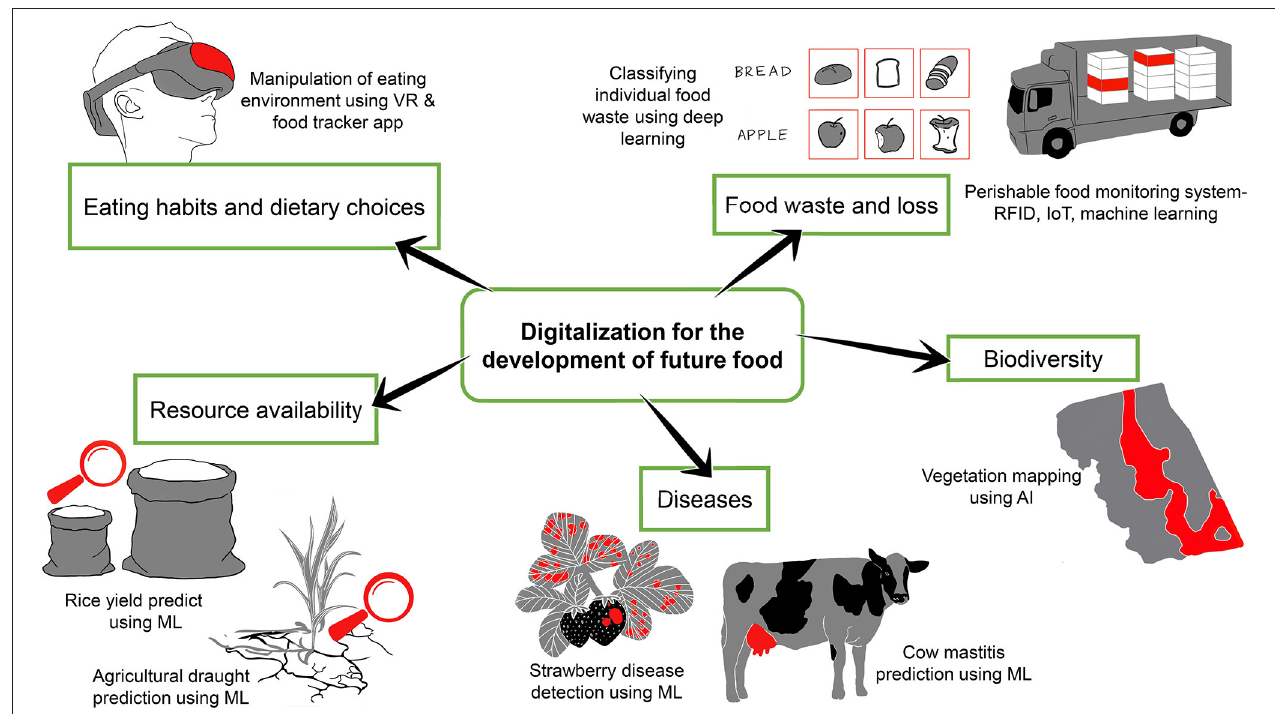
FIGURE 5 | Digitalization solutions for the development of future food. Red area represents digitalization-enabled targets. IoT, Internet of Things; ML, Machine Learning; RFID, Radio Frequency Identification; AI, Artificial Intelligence.